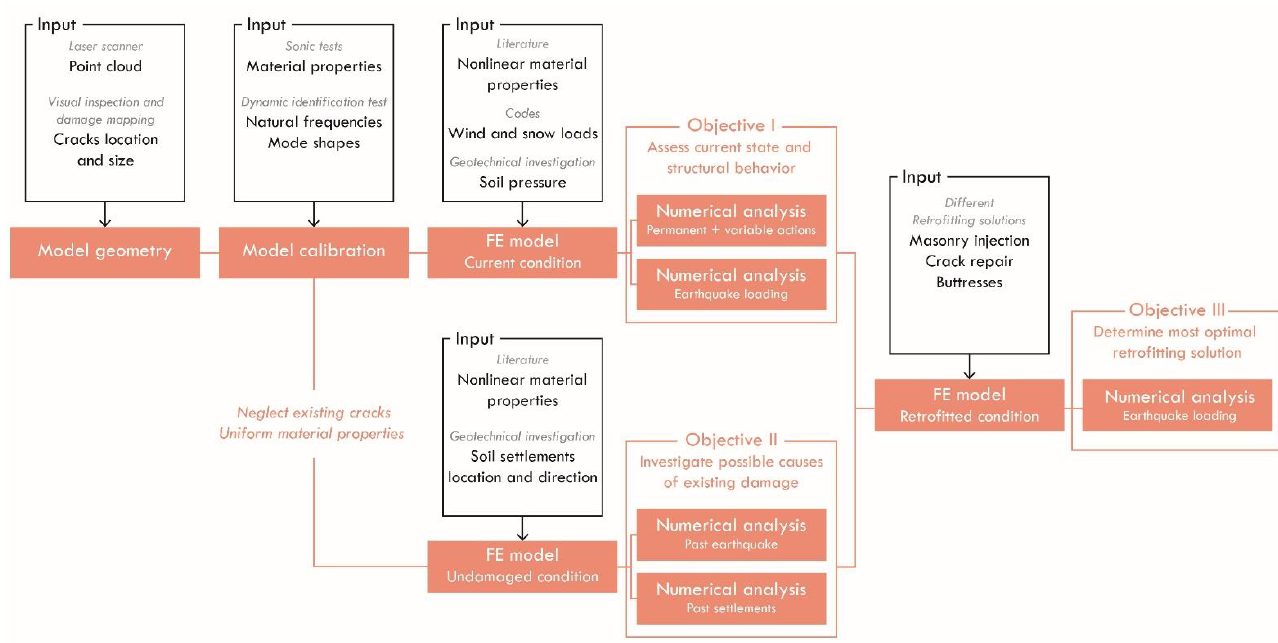
Figure 1. Schematic diagram of the methodology adopted for the numerical analysis and design of the retrofitting solution for the structure of the tower.